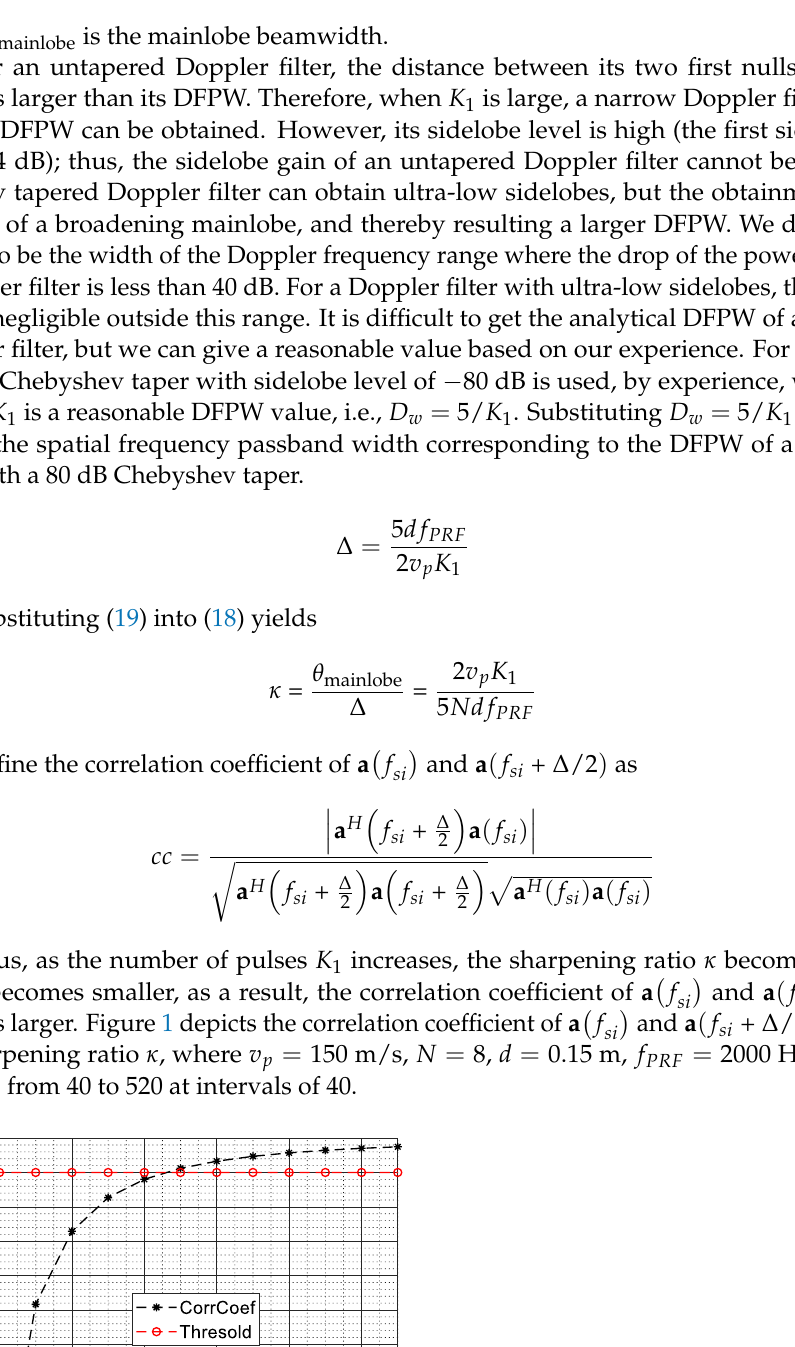
Figure 1. Correlation coefficient of a